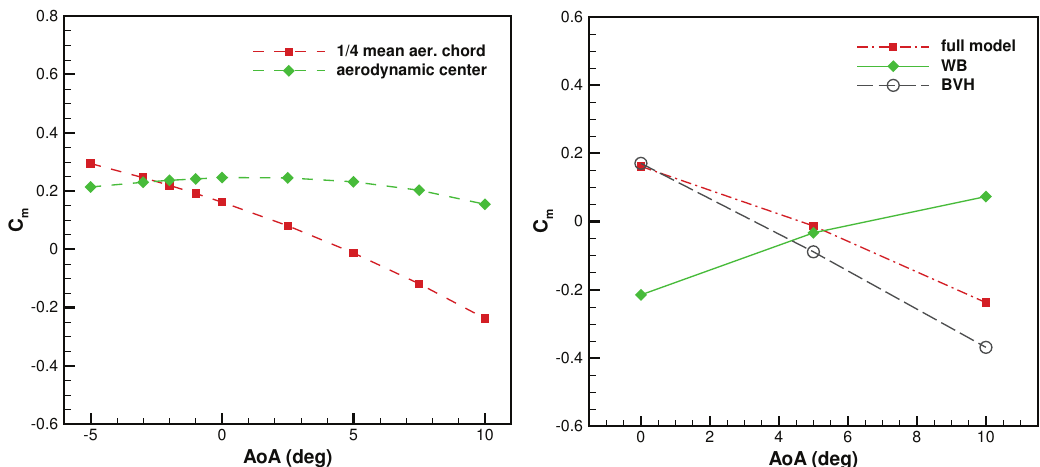
Figure 15. Clean configuration: pitching moment coefficient against AoA ( left ), and corresponding breakdown ( right